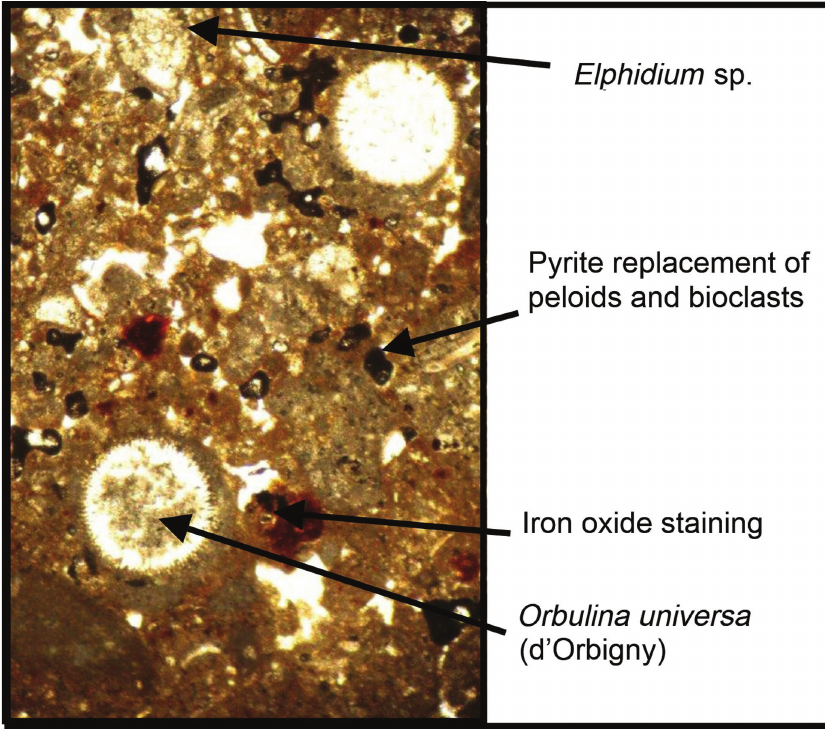
rML9 (11) of layer 9, photomicrograph of intergranular micrite and microspar cement binding the reworked bioclasts of Eocene into the serravallian–early Pliocene deposits. Note, selective pyrite replacement of allochthonous peloids and